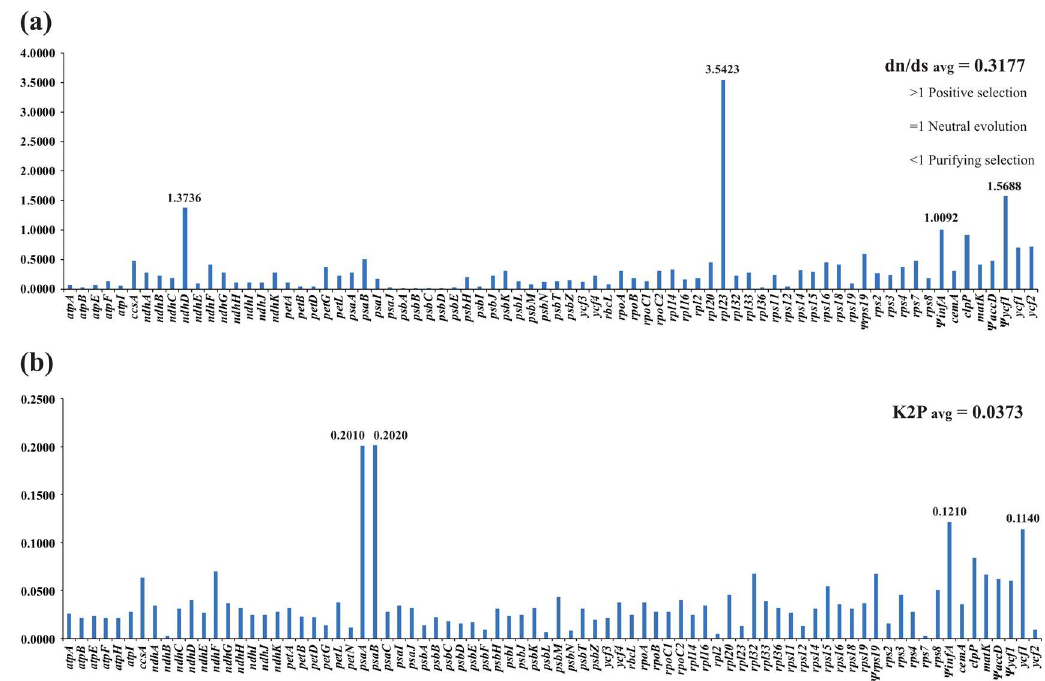
Figure 5. Evolutionary dynamics of genes in the cp genomes. ( a ) The dn/ds ratios for individual genes; ( b ) The K2P values for individual genes.